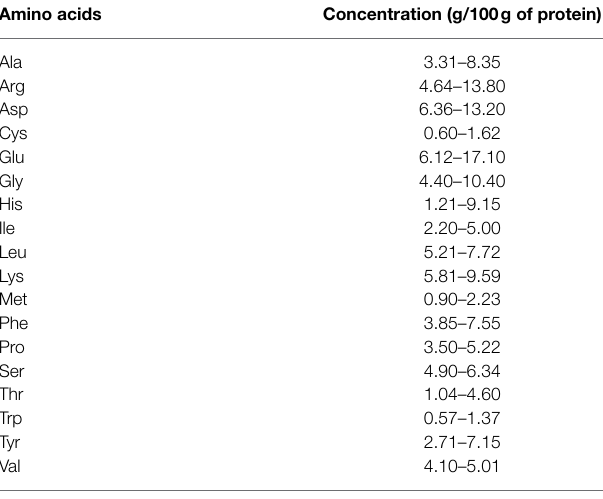
TABLE 2 | Amino acid profile of cultivated lentil genotypes (Sayeed and Njaa, 1985; Shekib et al., 1986; Kahraman, 2018). Amino